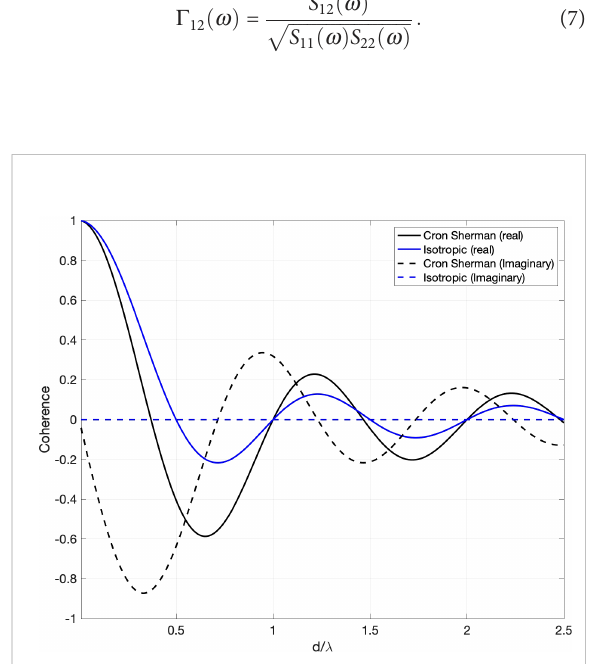
FIGURE 1 The real and imaginary vertical noise coherence according to the isotropic and Cron-Sherman models. Buckingham, M. J.